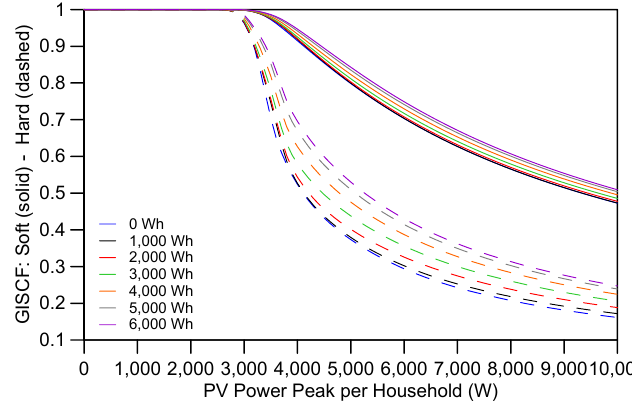
Figure 11. Annual GISCF variation with the installed PV power and storage capacity for soft curtailment (solid lines) and hard curtailment (dashed